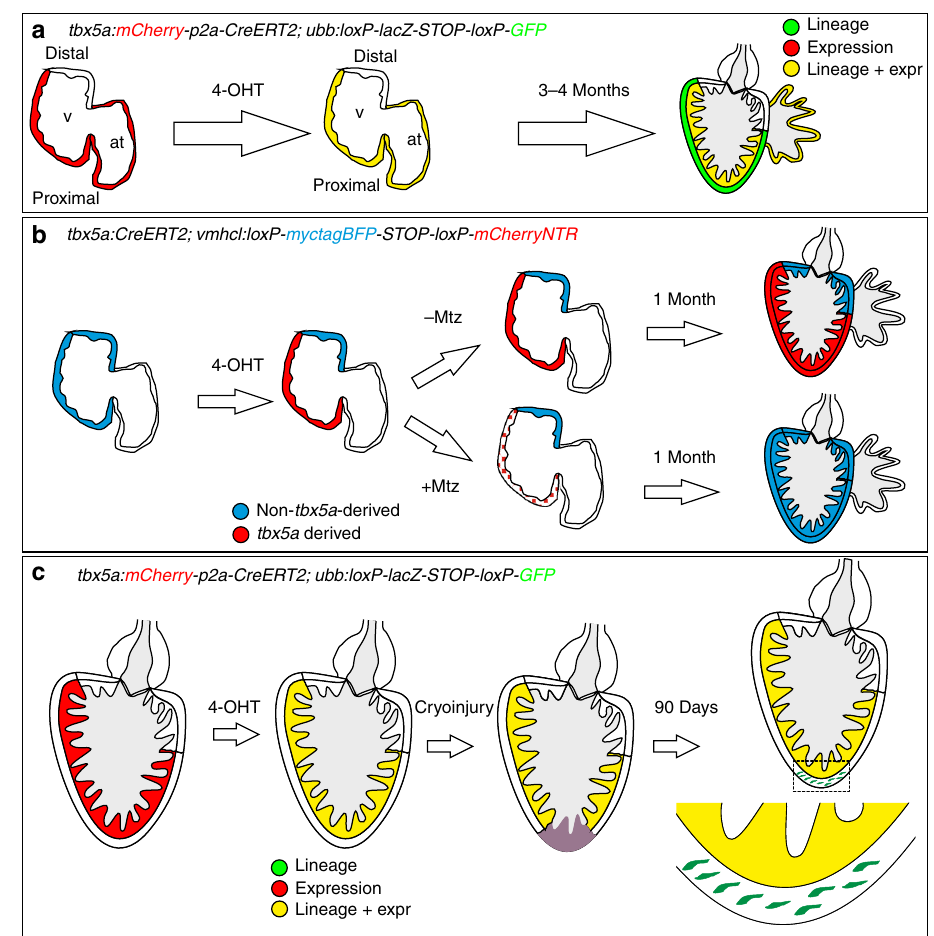
Fig. 10 Summary of the contribution of tbx5a -positive and -negative myocardium during heart development and regeneration. a Identi fi cation of tbx5a - expressing and tbx5a -derived cells in the zebra fi sh heart. Red, tbx5a + cells; green, tbx5a -derived cells not expressing tbx5a ; yellow, tbx5a -expressing cells derived from embryonic tbx5a + cells. b Replacement of the embryonic fi rst heart fi eld myocardium with second heart fi eld progenitors. Blue, ventricular cardiomyocytes; red, tbx5a -derived ventricular cardiomyocytes; dotted red, ablated tbx5a -derived ventricular cardiomyocytes. c Contribution of tbx5a - derived cells during heart regeneration in the zebra fi sh. Red, tbx5a + cells; green, tbx5a -derived cells not expressing tbx5a ; yellow, tbx5a -expressing cells derived from trabecular adult tbx5a + cells. 4-OHT, 4-Hydroxytamoxifen; at, atrium; Mtz, Metronidazole;